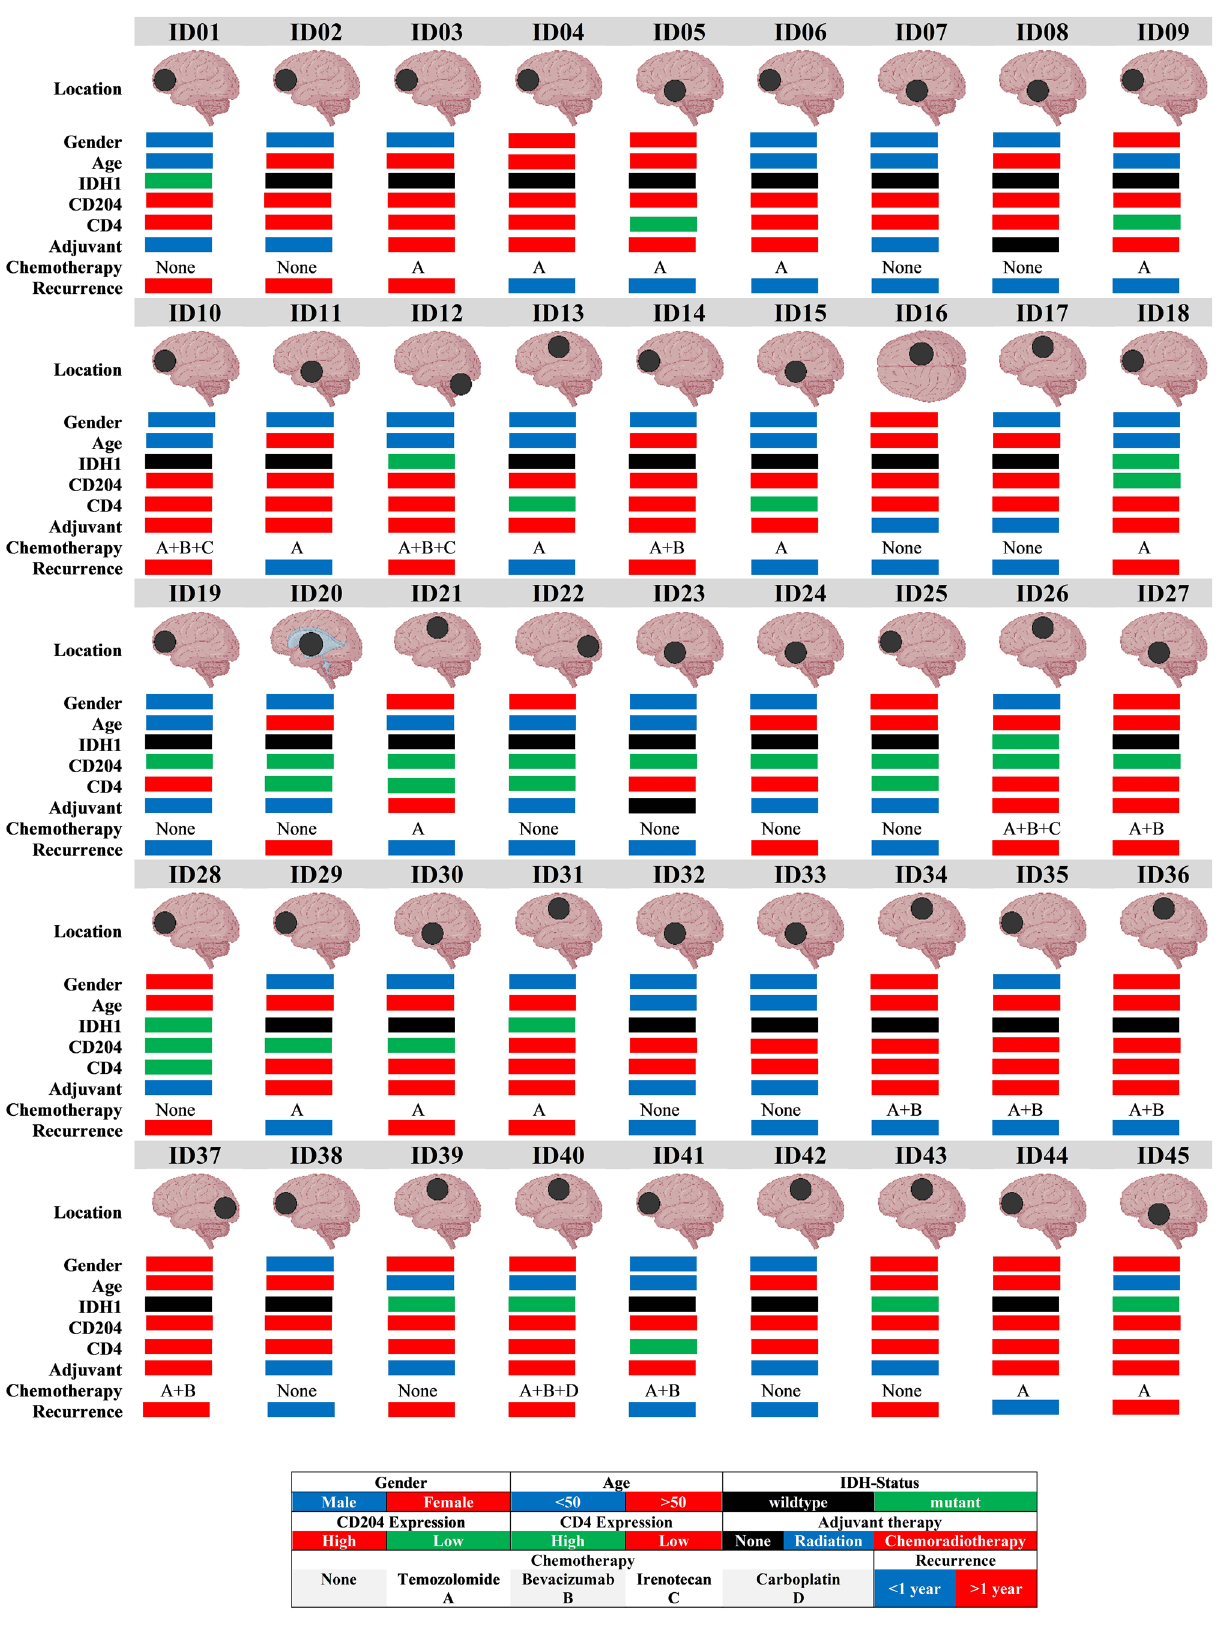
Fig. 2 Clinical and biological information of 45 glioblastoma patients enrolled in the study including age, gender, IDH1 mutation, expres- sion of CD204 + TAMs and CD4 + TILs, and their treatment protocol including chemotherapeutic agents, and